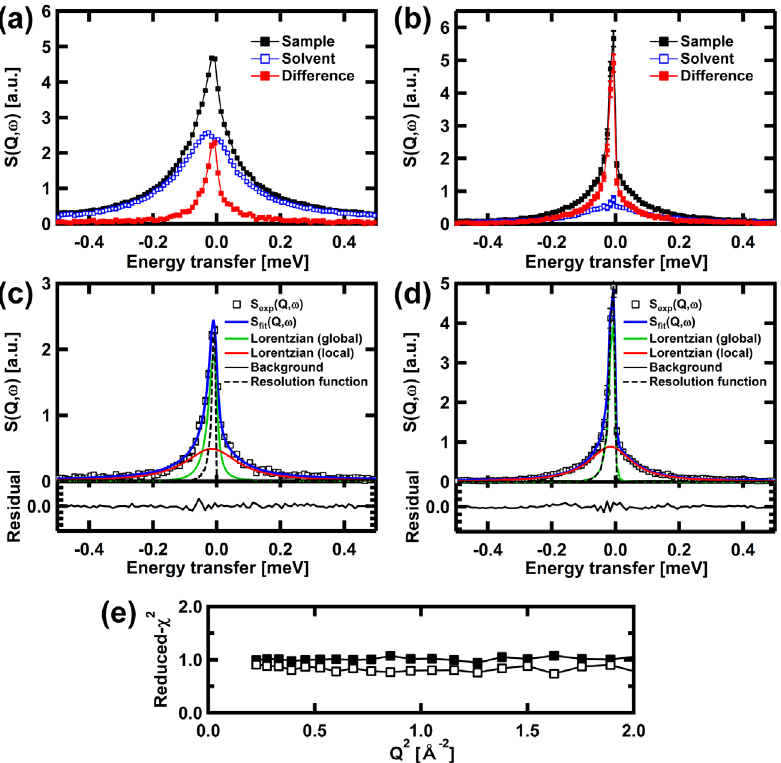
Fig 1. Examples of quasielastic neutron scattering spectra, S(Q, ω ). The spectra of the samples, the solvent, and the difference spectra between the sample and the solvent, of α Syn in (a) the monomeric state and (b) the fibril state, at Q = 1.225 Å -1 and at 280 K, are shown. Filled symbols in black and open symbols in blue show the spectra of the sample solutions and those of the solvent, respectively. The spectra of the empty cell were subtracted from these spectra. Filled symbols in red show the difference spectra between the sample and the solvent. (c) Fits using Eq 1 to the difference spectra, which are due to monomeric α Syn molecules in the sample solution. (d) Fits to the difference spectra, which are due to α Syn molecules in the fibril state. In the upper panels, open squares denote the data, thick solid lines in blue denote the total fits, solid lines in green and red denote the narrow and wide Lorentzian functions, corresponding to L global (Q, ω ) and L local (Q, ω ), respectively, thin solid lines in blue show the background, and dashed lines in black show the resolution functions. The lower panels show the residuals of the fits. (e) Reduced- χ 2 of the fits to the data. Filled squares and open squares are for the values to the data of α Syn in the monomeric state and the fibril state, respectively, at 280 K. Note that similar values of Reduced- χ 2 were obtained for the data measured at other